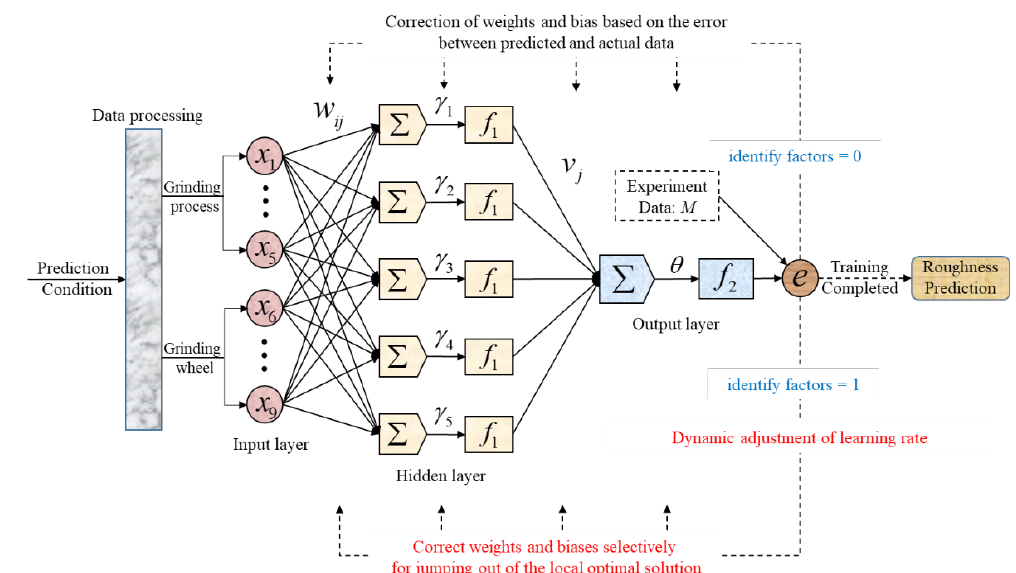
Figure 3. Presented BP neural network with single hidden layer.